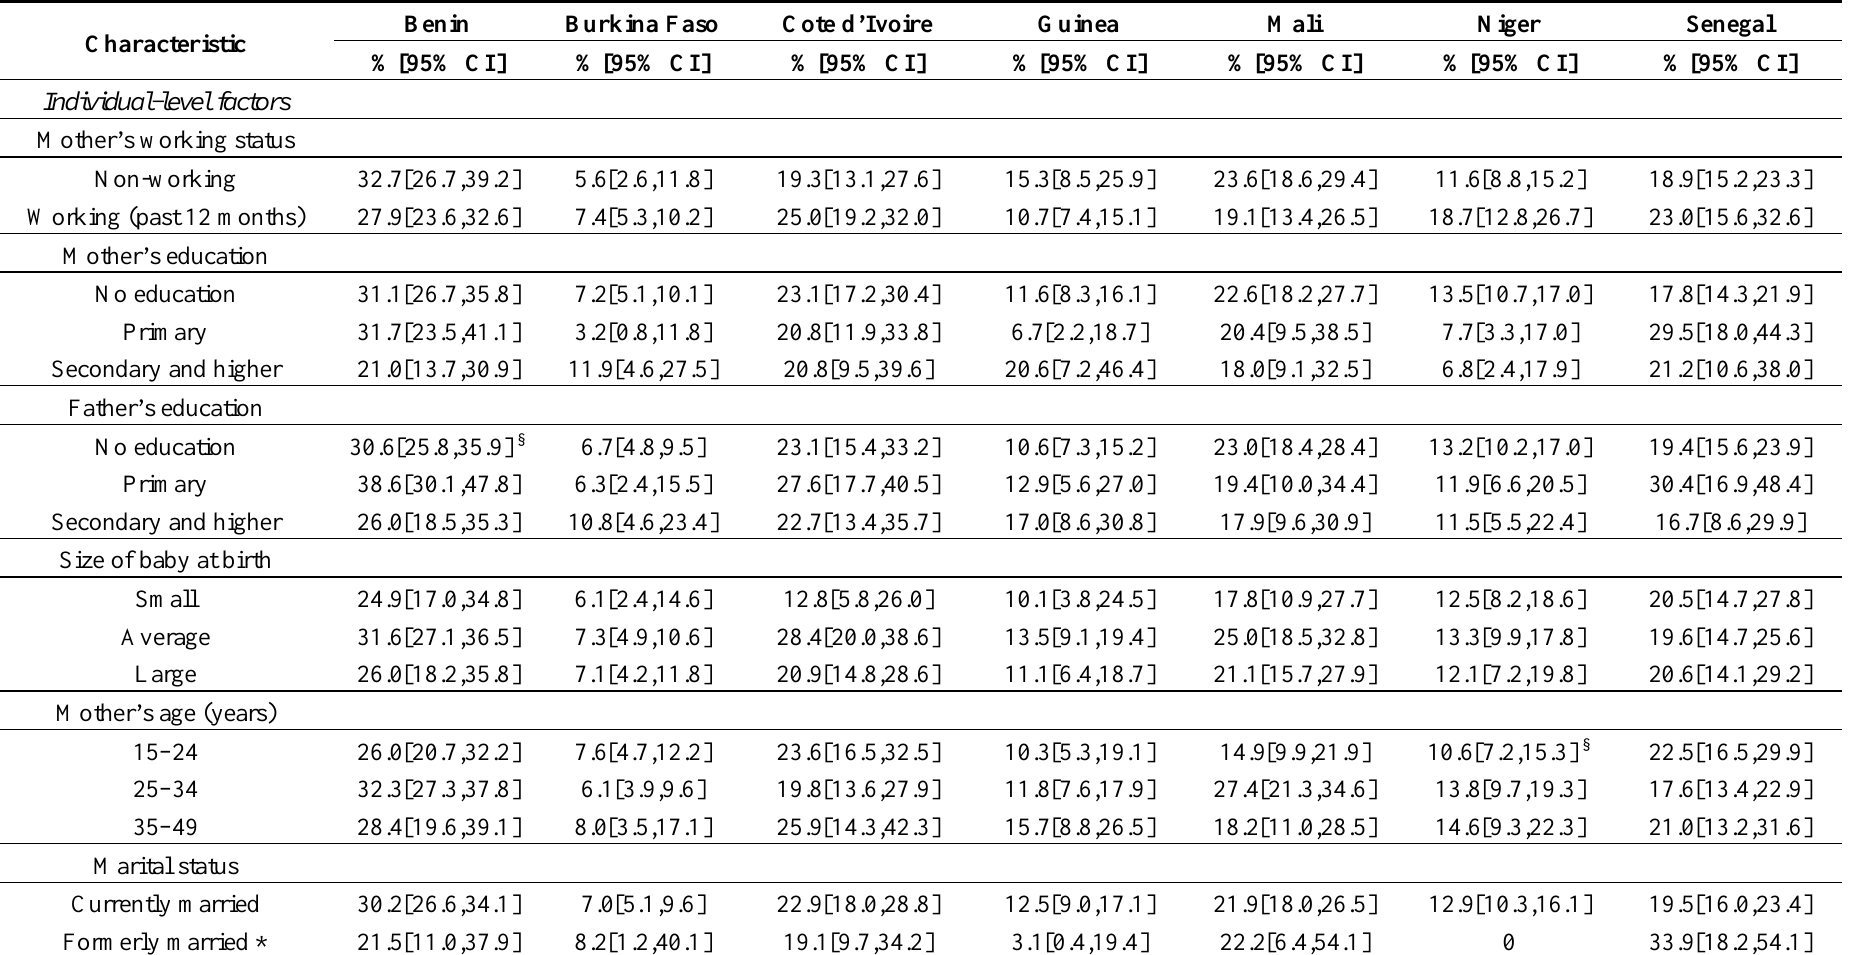
Table 2. Early introduction of solid, semi-solid or soft foods among infants aged three to five months by individual-, household- and community- level characteristics in seven Francophone West African countries,